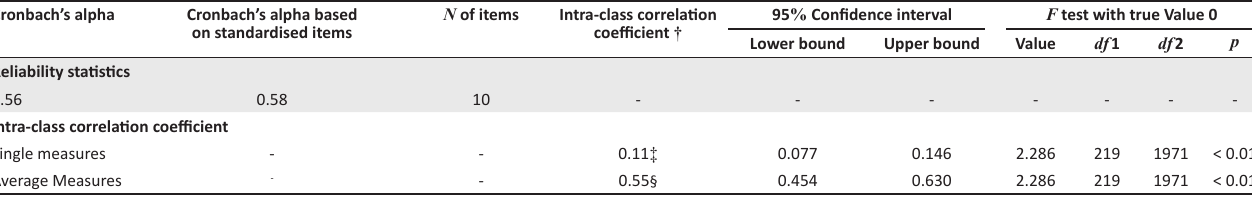
TABLE 3: Cronbach’s alpha and intra-class correlation coefficient of the Drug Attitude Inventory. Cronbach’s alpha Cronbach’s alpha based on standardised items